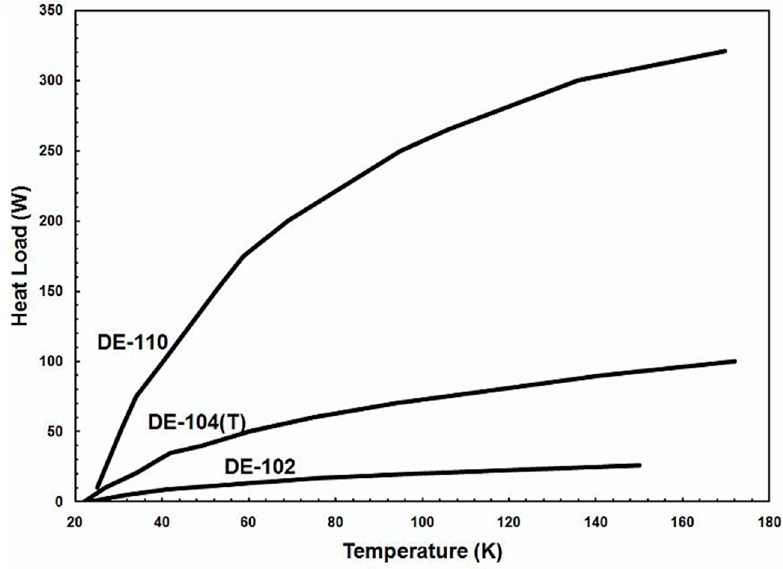
Figure 18. Cryocooler cooling